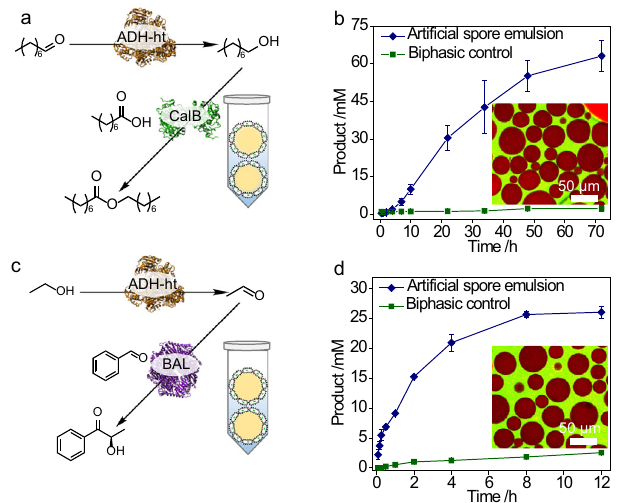
Fig. 7 Investigation of multienzyme cascades. a Cascade reaction with alcohol dehydrogenase from Bacillus stearothermophilus (ADH-ht) and CalB, b their reaction pro fi les in arti fi cial spores emulsion (blue) and biphasic control (green), inset is the emulsion picture by CLSM; red – organic phase, green – aqueous phase. c Cascade reaction with ADH-ht and BAL, and ( d ) their reaction pro fi les in arti fi cial spores emulsion (blue) and biphasic control (green), inset is the emulsion picture by CLSM; red – organic phase, green – aqueous phase. The results in ( b , d ) are the average values of three parallel experiments. The error bars represent the standard deviations of three parallel measurements, n =